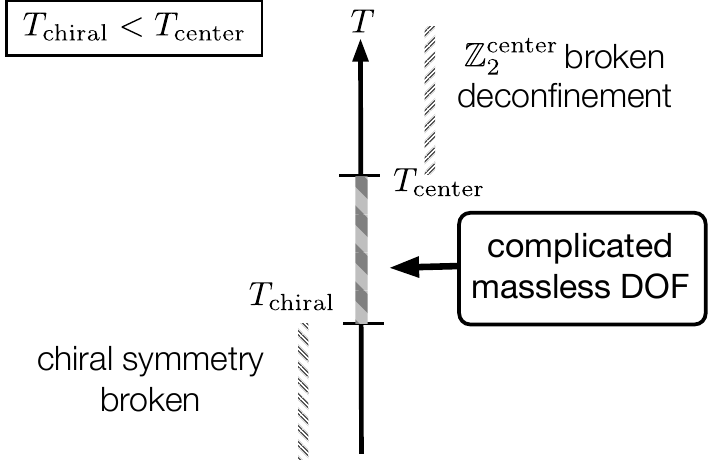
Figure 3 . The case T chiral < T center . We need massless degrees of freedom (DOF) in the region T chiral T T center to match the ’t Hooft anomaly. The required DOF is very complicated, as (cid:20) (cid:20) explained in the main